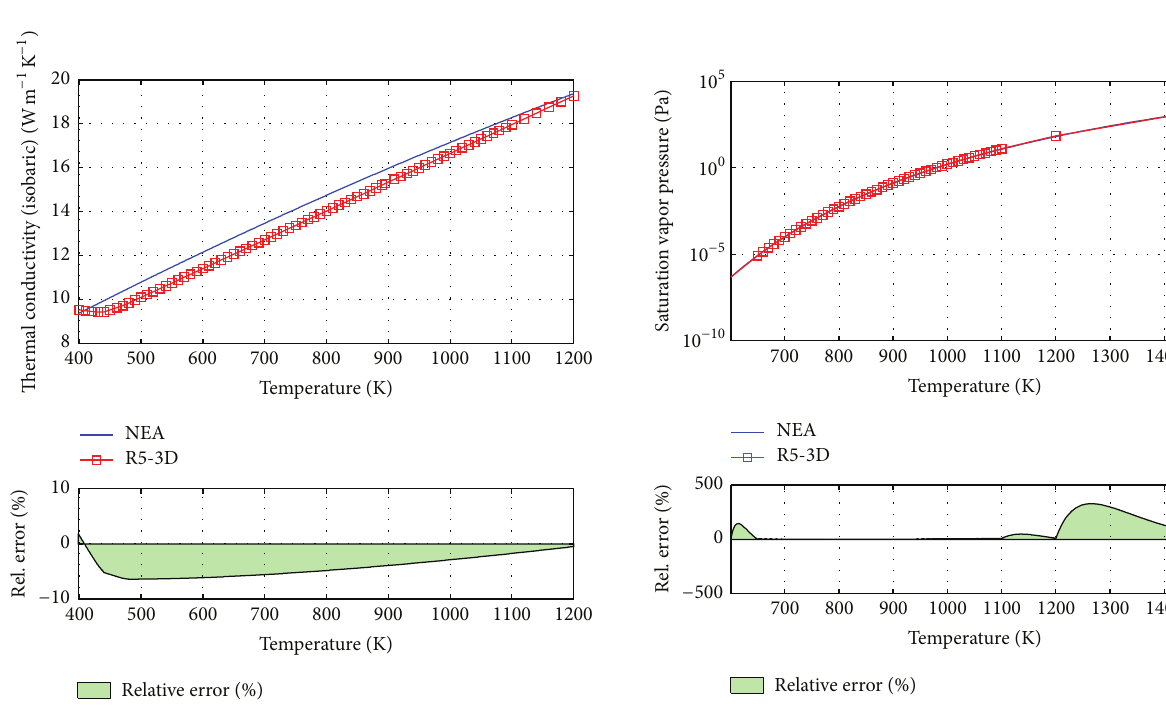
Figure 7: Lead saturation vapor pressure, original R5-3D “tpf” file versus NEA